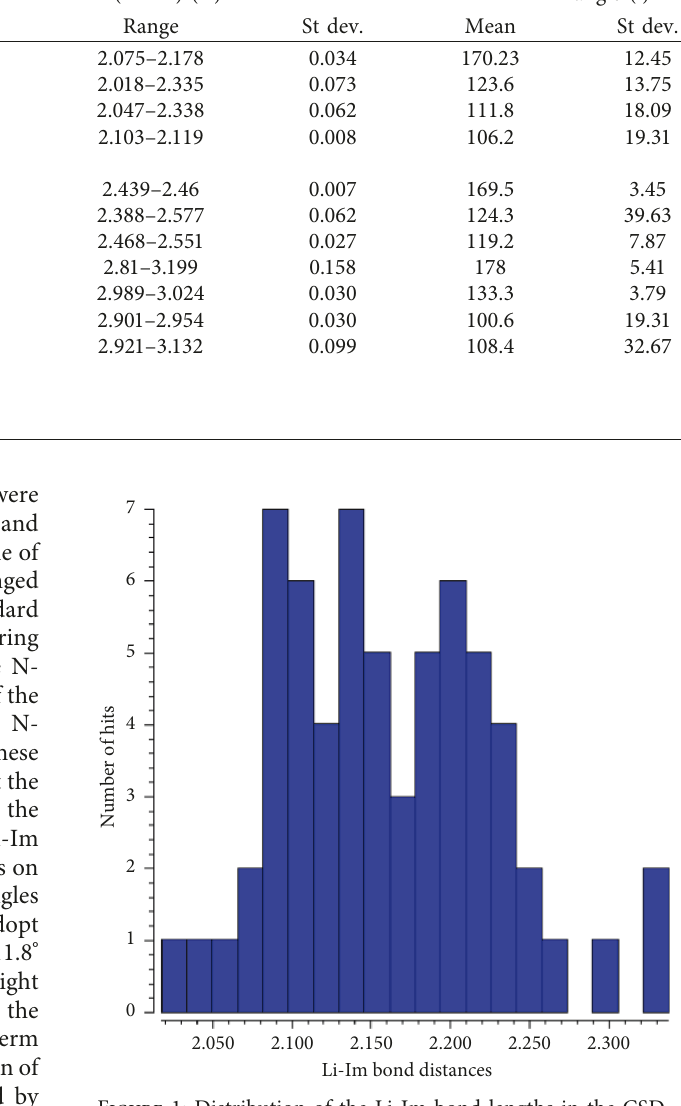
Table 1: The number of entries (hits), coordination number (CN), and bond parameters of group IA metal-imidazol-2-ylidene complexes. Metal CN No. of hits